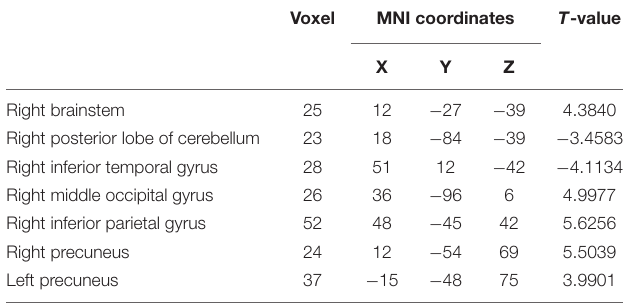
TABLE 2 | Cerebral ReHo changings in TOF group.